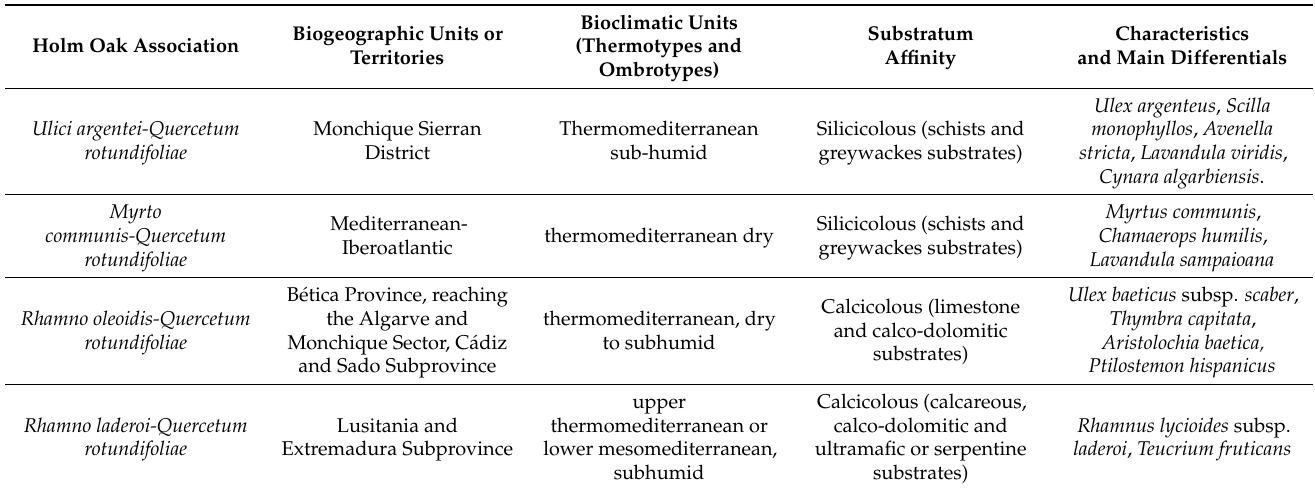
Table A2. Biogeographic, bioclimatic, substratum and floristic comparison between holm oak communities of the South- western Iberian Peninsula, included in the Querco rotundifoliae-Oleenion sylvestris suballiance. Holm Oak Association